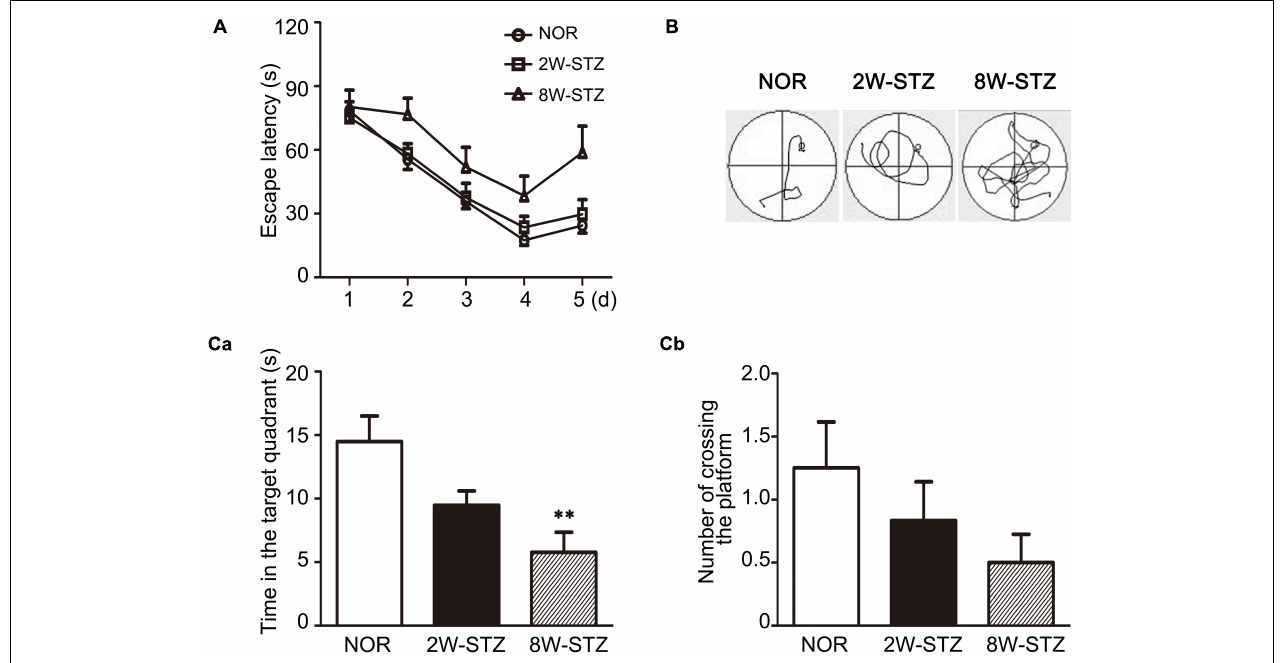
FIGURE 2 | Cognitive performance of diabetic rats was worse in acquisition trial and probe test of Morris water maze test. (A) Line graphs showed the change in escape latency from day 1 to day 5 among 2W-STZ, 8W-STZ and normal groups. The sequence of start position was shifted each day and the hidden platform was fixed in the quadrant NE. p = 0.003, 8W STZ vs. normal rats. p = 0.028, 2W-STZ vs. 8W-STZ. (B) The track plot showed the trace of rats from the start position to the platform (circle) in the tank during the spatial acquisition trials. (C) The platform was removed in the probe test. Bar graph showed the time spent in the target platform quadrant (Ca) and the number of crossing the original platform area (Cb) . The time spent in the target quadrant of 8-week STZ rats significantly decreased (Ca) compared to the normal rats. There was no difference in the number of crossing the platform among groups (Cb) . Data are mean ± SEM, n = 6–8 per group, ∗∗ p < 0.01, 8W-STZ vs. normal rats. NOR, normal rats; 2W-STZ, 2-week STZ; 8W-STZ, 8-week STZ.